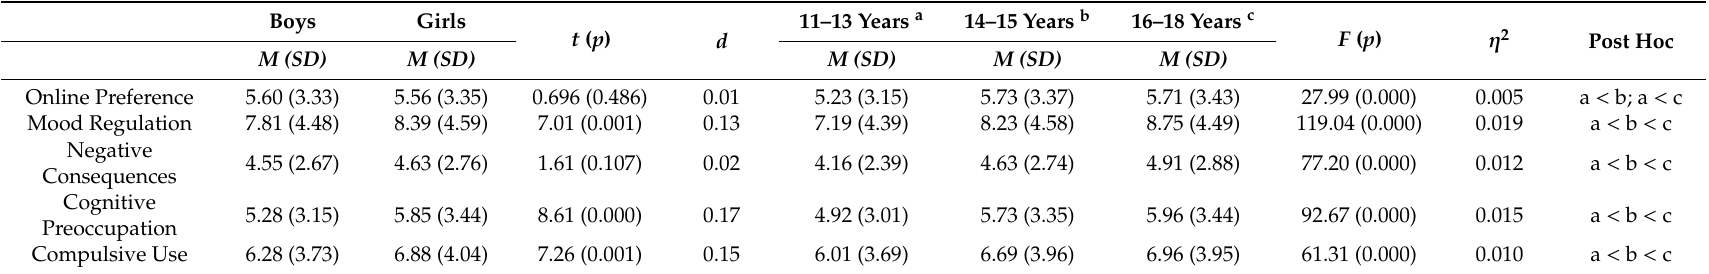
Table 1. Di ff erences as a function of the variables sex and age groups (11–13 years, 14–15 years, and 16–18 years) in the Generalized and Problematic Internet Use Scale-2 (GPIUS2) dimensions.